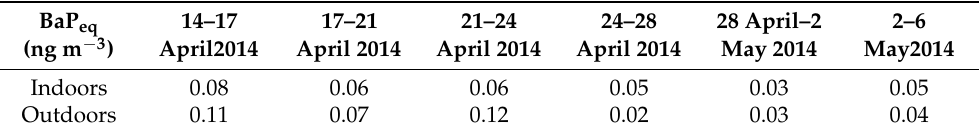
Table 4. Evaluation of BaP eq indicator during the whole field